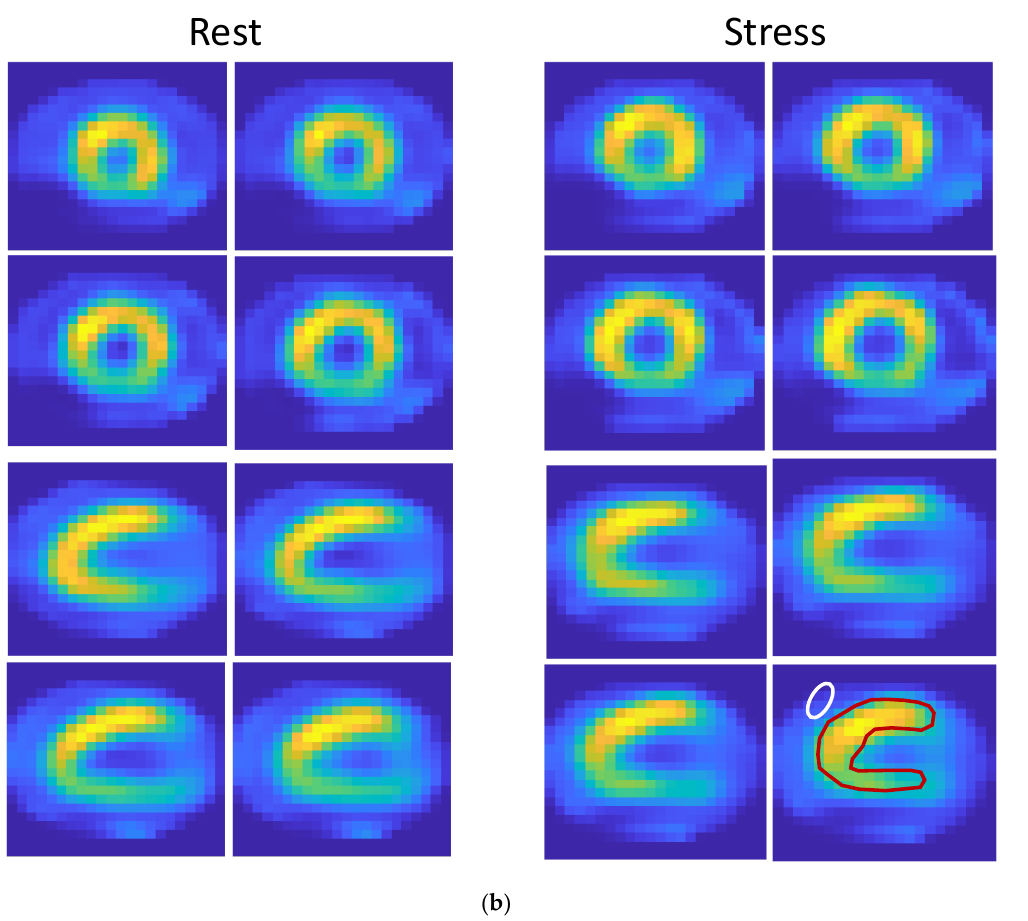
Figure 5. Images from a patient, in rest and stress conditions; the first two rows are relevant to cardiac short axis views; the last two rows are long axis views. ( a ) Images acquired by Alcyone ( b ); images acquired by Discovery. In the lower right image in b, the ROIs covering myocardium (in red) and background (in white) are shown as an example to show where ROIs have been selected for numerical analysis (i.e., uniformity, SBNR, and TCBNR).